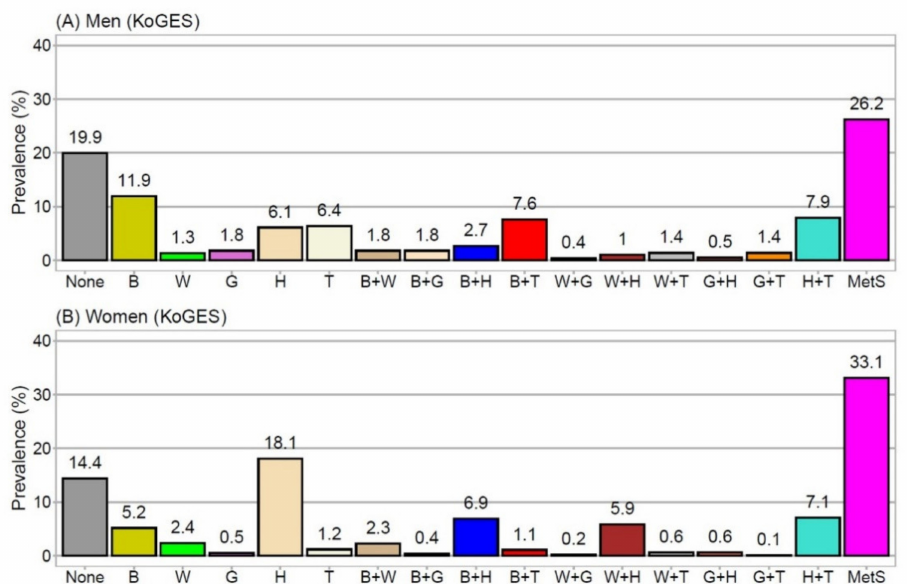
Figure 2. Prevalence of each MetSyn component, combinations of two MetSyn components, and MetSyn. ( A ) prevalence in men, ( B ) prevalence in women. Numbers located above the bars represent the numerical prevalence values. All groups are mutually exclusive; thus, the sum of prevalences was 100%. Colors for each component and combination are the same as those used in Figures 3 and 4 to facilitate visual comparisons. B, elevated blood pressure; G, elevated glucose; H, low HDL-cholesterol; KoGES, Korean Genome and Epidemiology Study Ansan and Ansung; MetSyn, metabolic syndrome; T, elevated triglycerides; W, increased waist